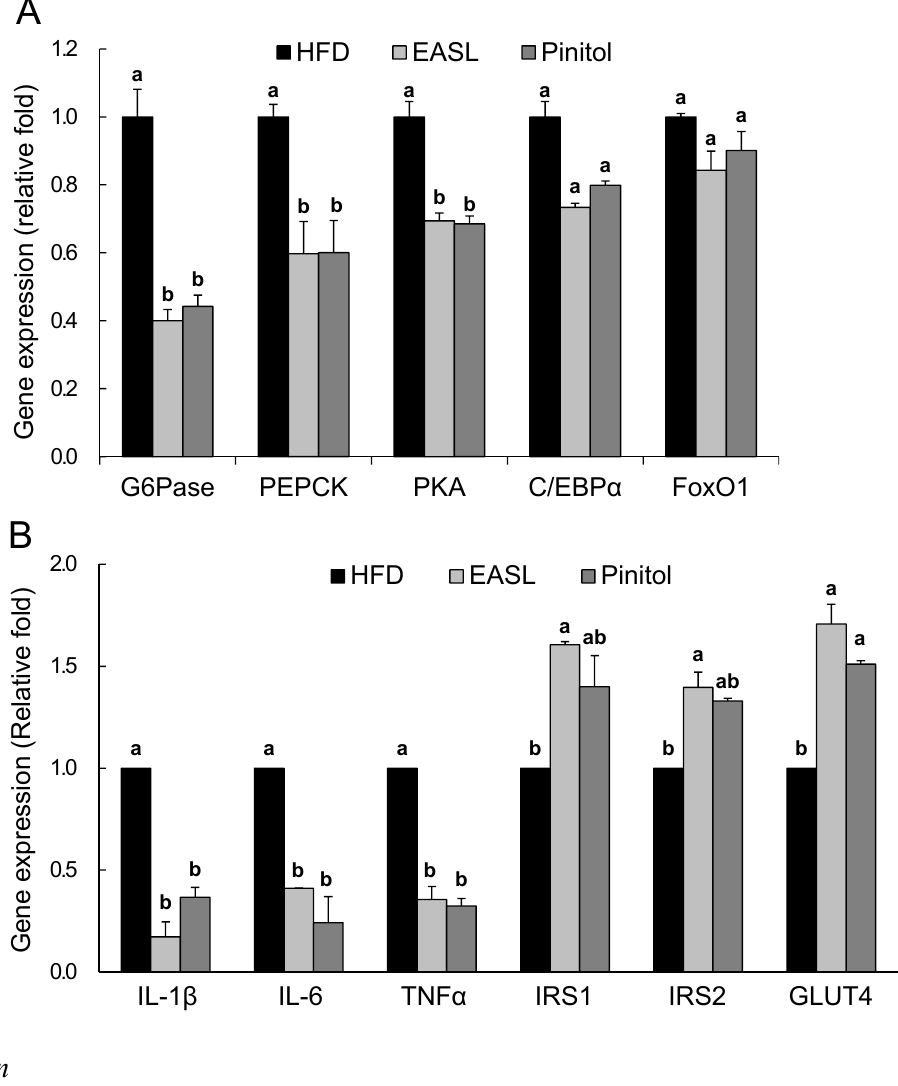
Figure 4. Effects of EASL dietary supplementation on the relative mRNA expression levels of genes in the liver and WAT. Expression was measured by qRT-PCR for genes involved in gluconeogenesis ( A ) and insulin sensitivity ( B ) and then normalized to GAPDH expression. Values are presented as mean ± SE. a,b Means not sharing a common letter are significantly different between groups ( p <